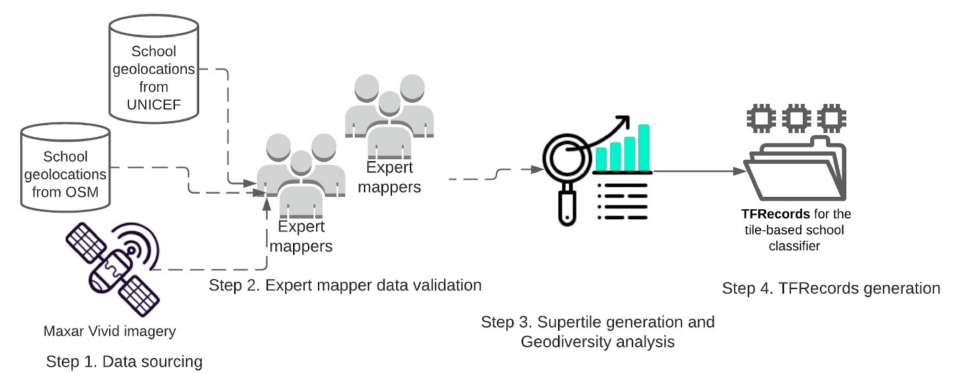
Figure 4. Steps followed to generate the model training dataset